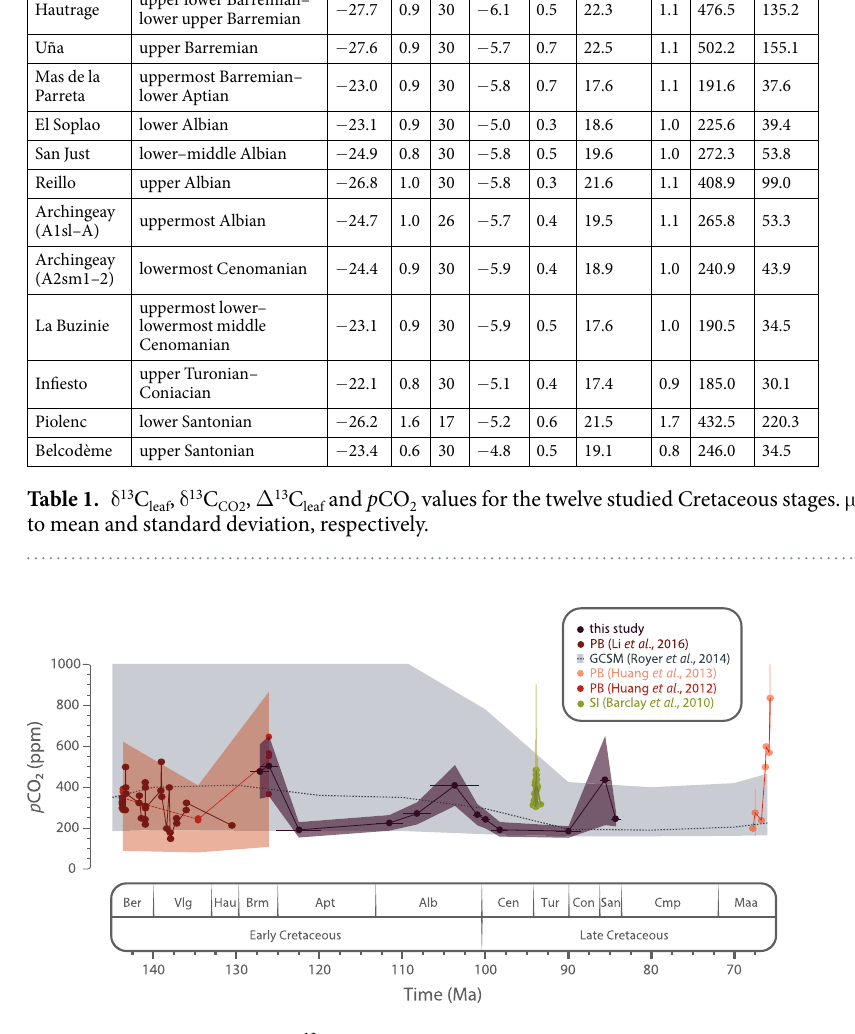
Figure 2. Comparison of the δ 13 C leaf -based p CO 2 estimates with most recent proxy-based and model- based p CO 2 reconstructions for the Cretaceous 3, 7–10 . Envelopes and bar errors represent ± 1 σ . GCSM: GEOCARBSULF Model reconstructions; PB: Paleosol Barometer reconstructions; SI: Stomatal Index